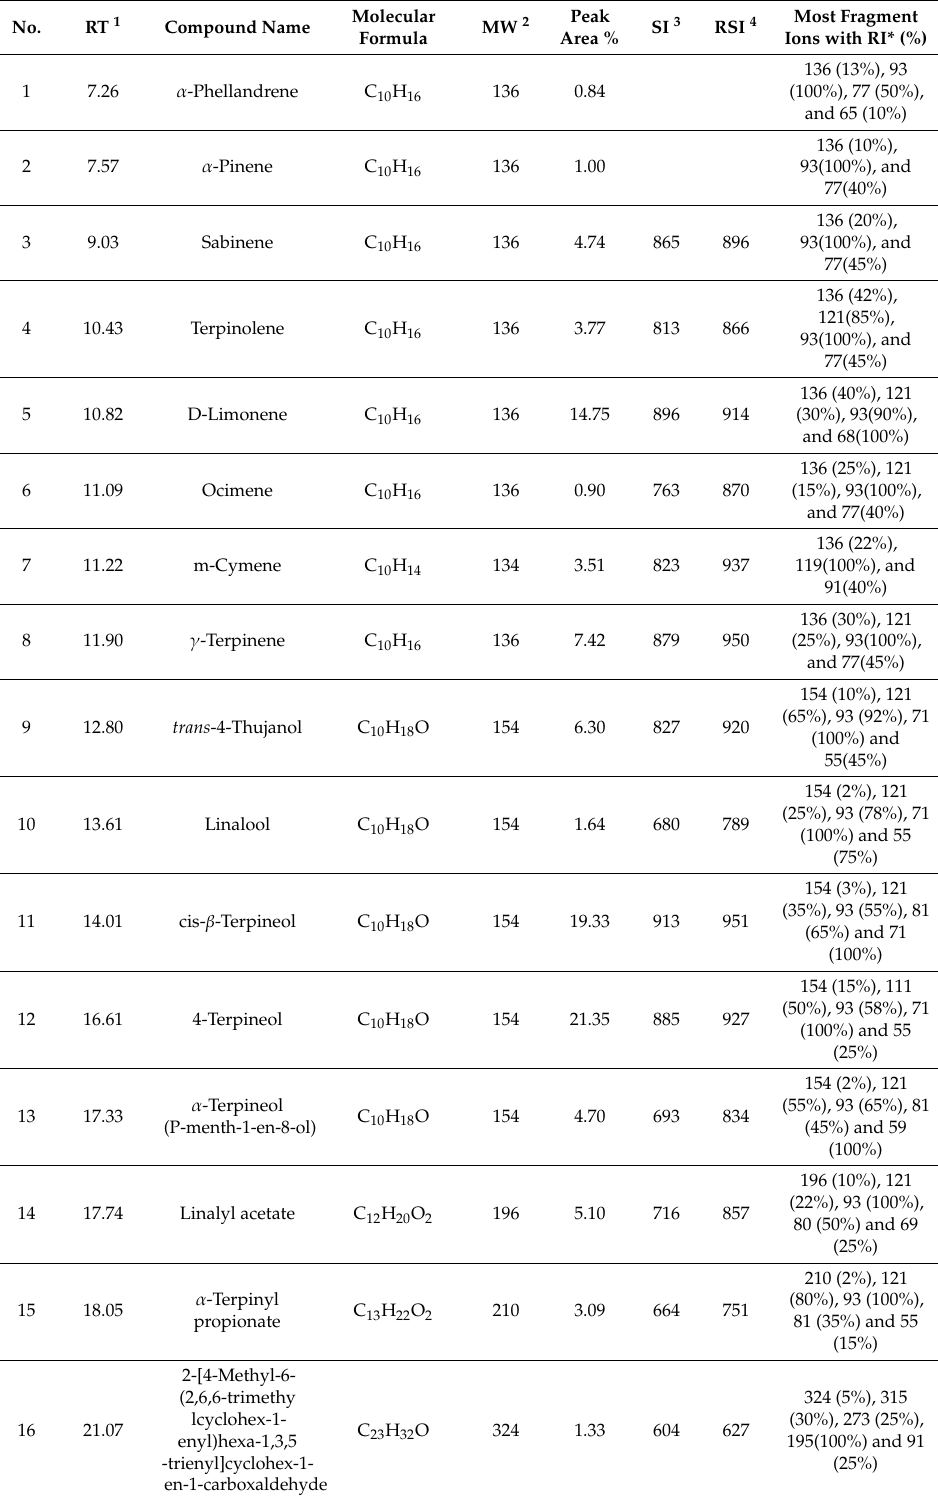
RI* relative intensities, 1 . RT: Retention Time 2 . MW: Molecular Weight (g / mol), 3 . SI: Standard Index, 4 . RSI: Reverse Standard